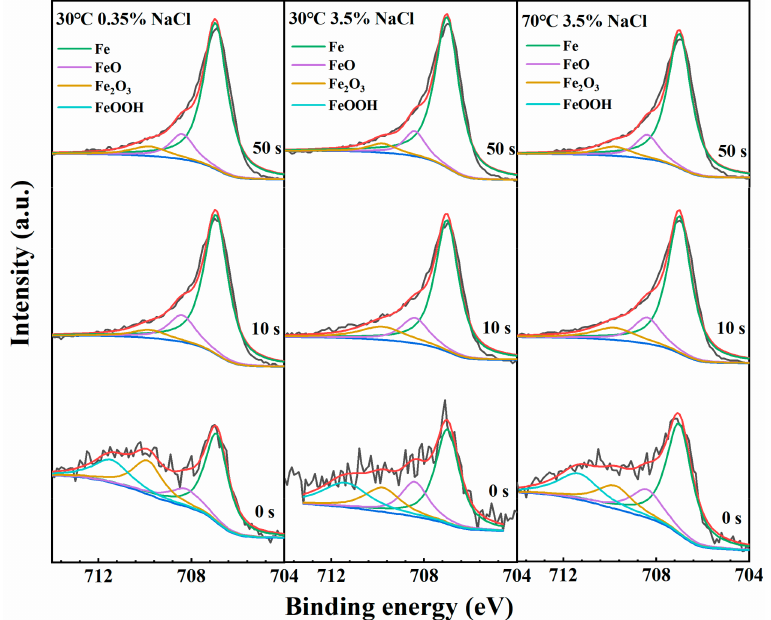
Figure 8. The detailed XPS spectra of Fe 2p 3/2 in the film on Fe-based AMCs with different sputtering times in the NaCl solution with various concentration and